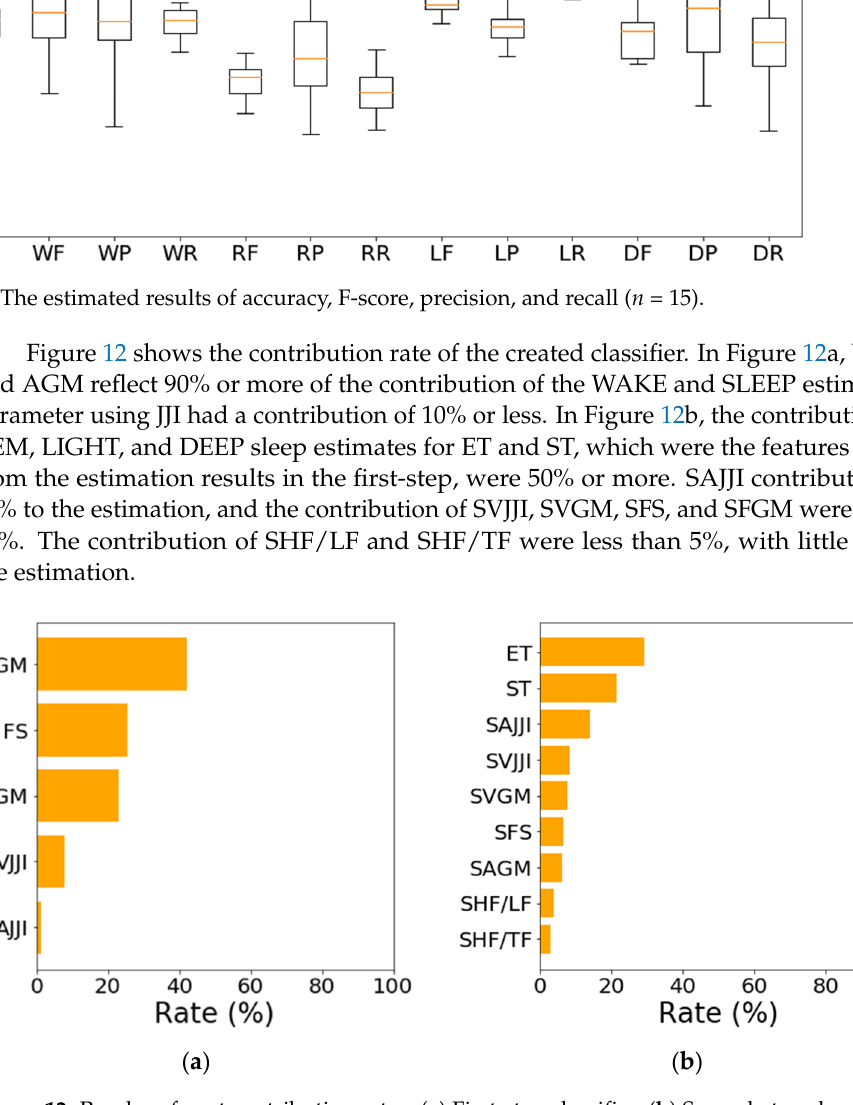
Figure 12. Random forest contribution rates: ( a ) First-step classifier; ( b ) Second-step classifier.